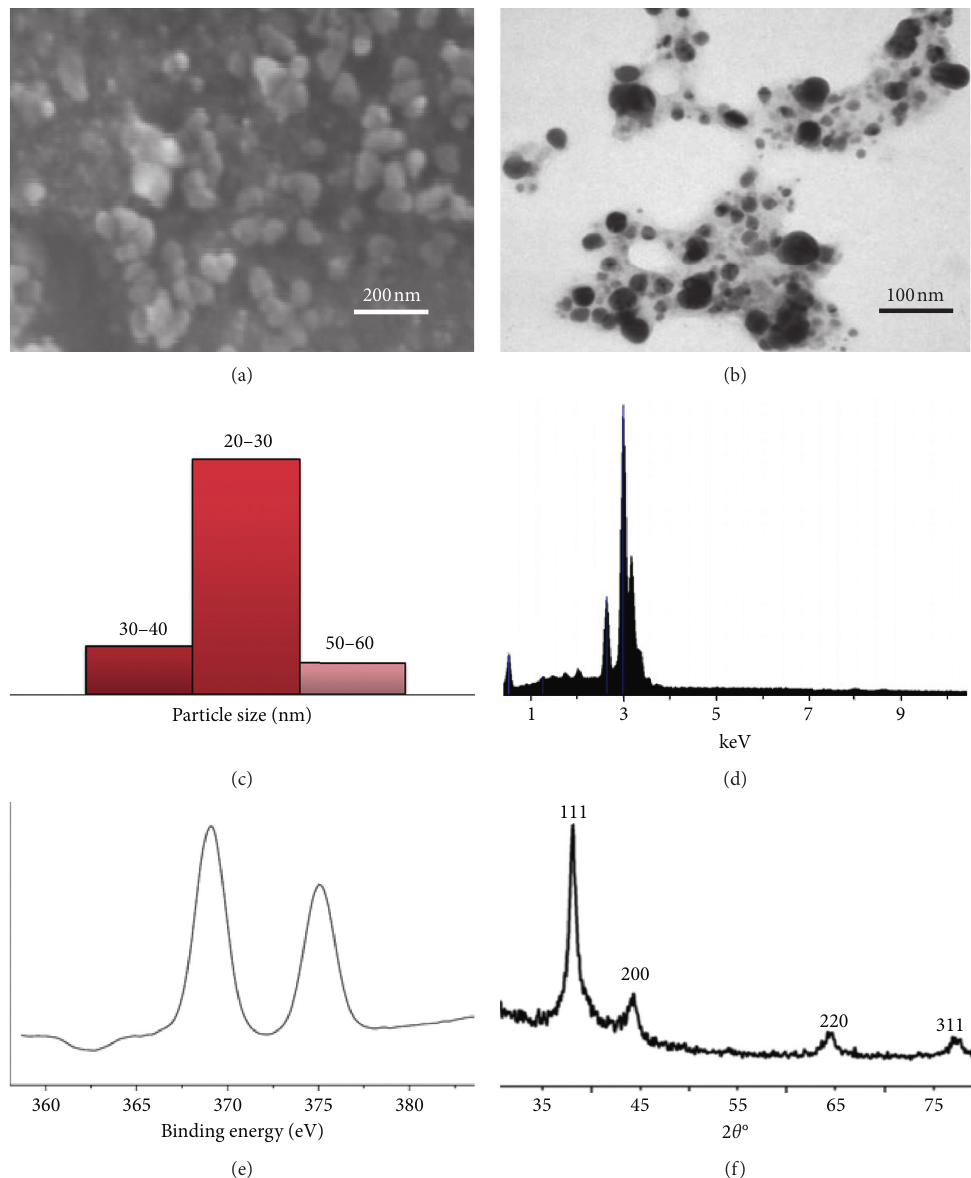
Figure 2: Characterization of silver nanoparticles formed with 90mL of 10–3M aqueous AgNO micrograph, (b) TEM micrograph, (c) diameter particles diameter with counts, and (d) EDS spectrum, (e) XPS spectrum, and (f) XRD